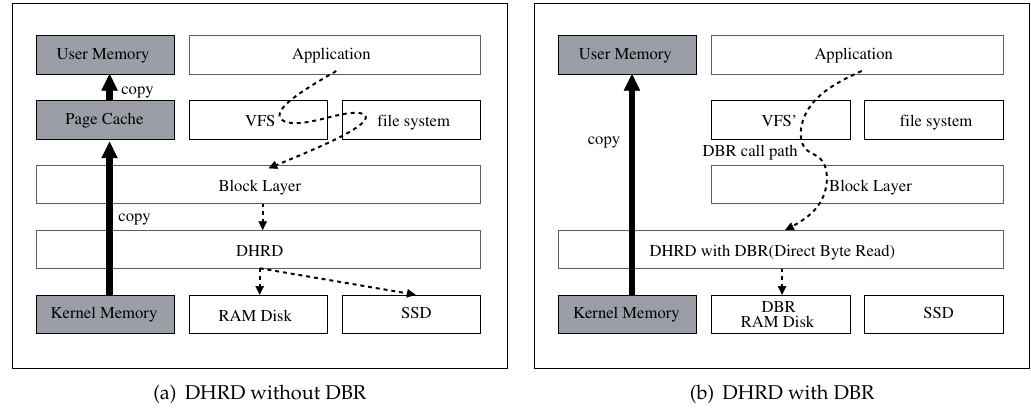
Figure 5. Software stack of DHRD for the cases of redundant memory copy and direct byte